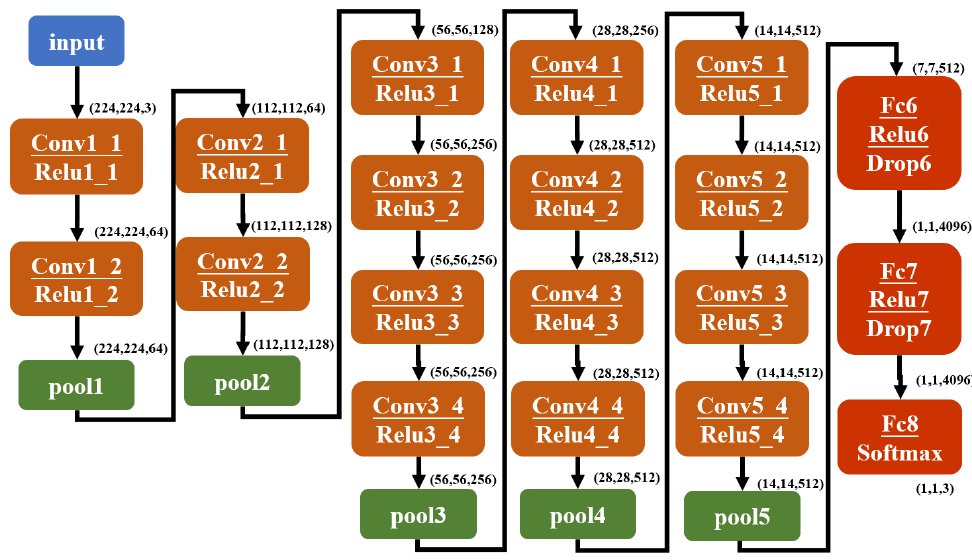
Figure 3. Detailed architecture diagram of the VGG19 network.